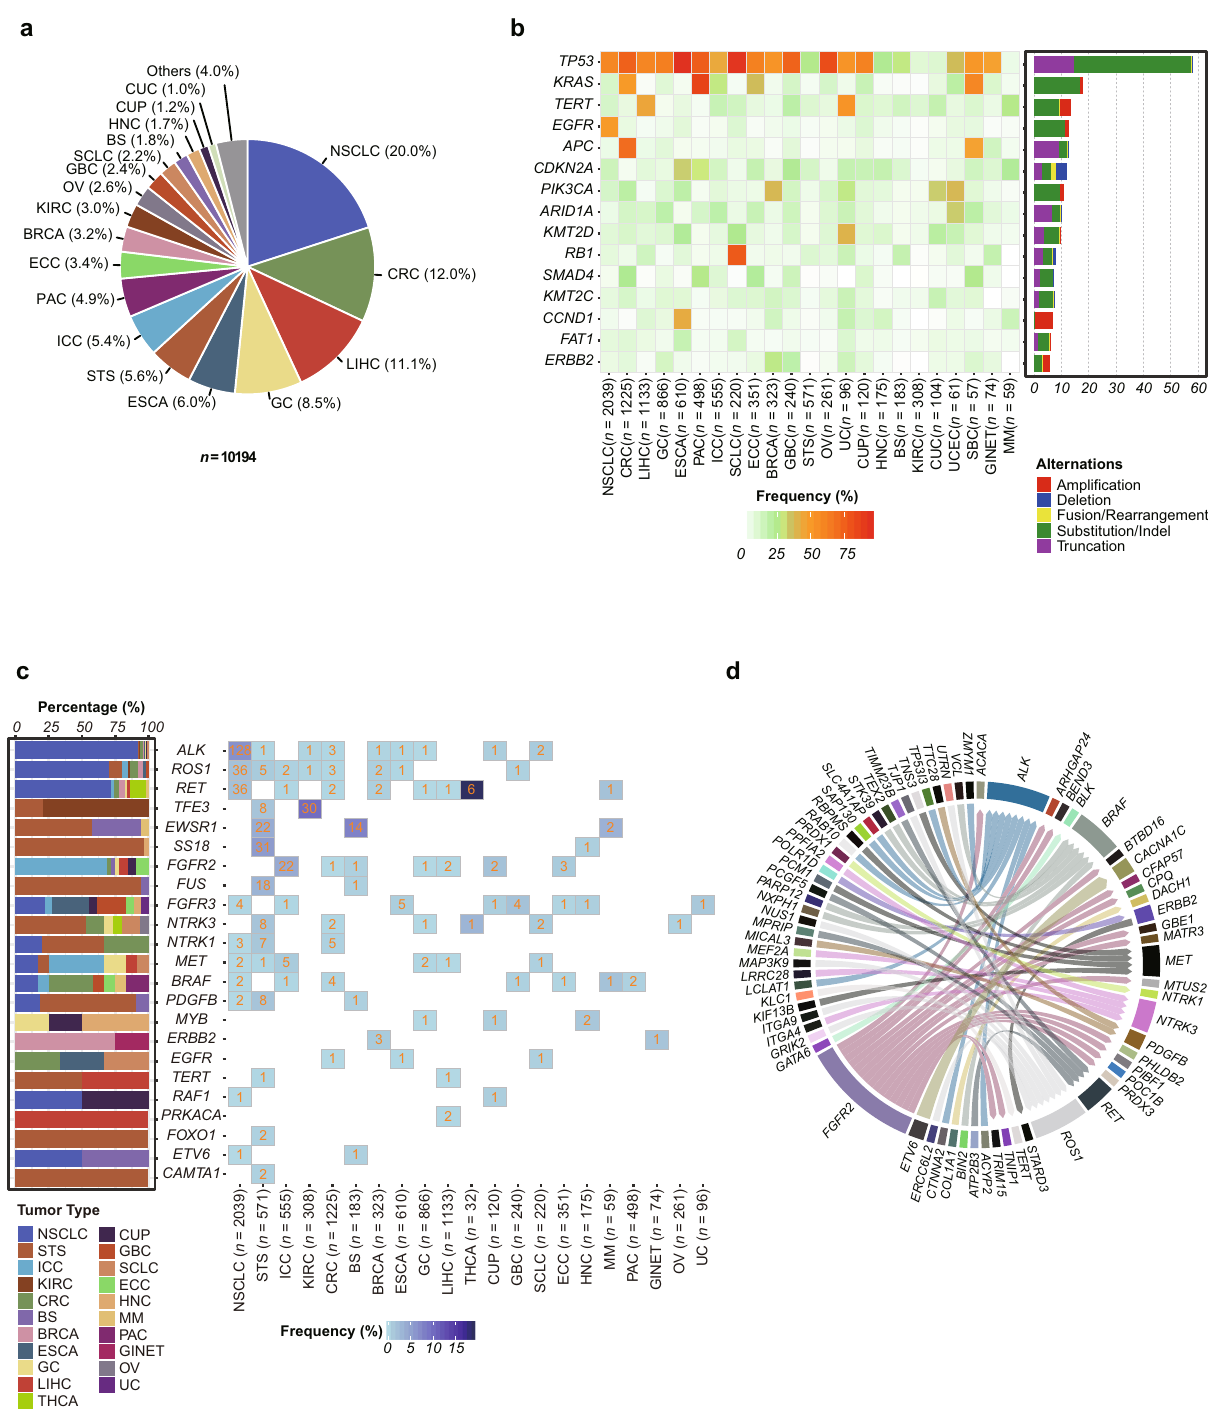
Fig. 1 Overview of the mutational landscape of solid tumors from Chinese patients. a Distribution of tumor types among cases successfully sequenced from 10,194 patients. b Recurrent somatic alterations across common tumor types. The top 15 Tier 1 Cancer Gene Census oncogenes and tumor suppressor genes with a cohort-level variation frequency of ≥ 6% were shown, in descending order. Bars represent the percent of cases within each tumor type having at least 1 of 5 different classes of genomic alterations. c Genes recurrently rearranged to form putative gene fusions were displayed across principal tumor types. The tumor type-speci fi c distribution of these genes was presented on the left side (various colors represent different tumor types). The number of corresponding gene fusions in each tumor type was shown in the right boxes, and the frequency was shown in gradient blue. d Gene fusions across multiple tumor types. A total of 57 driver-partner relationships were detected spanning 71 genes. The thickness of the line between two genes implied the relative